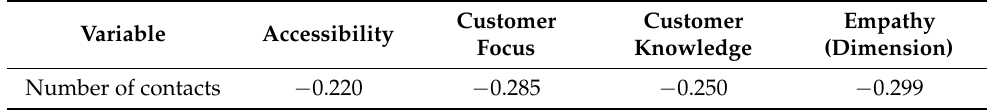
Table 12. Pearson correlation coefficients for the reliability dimension and its three features. All correlations are significant at the 0.01 level